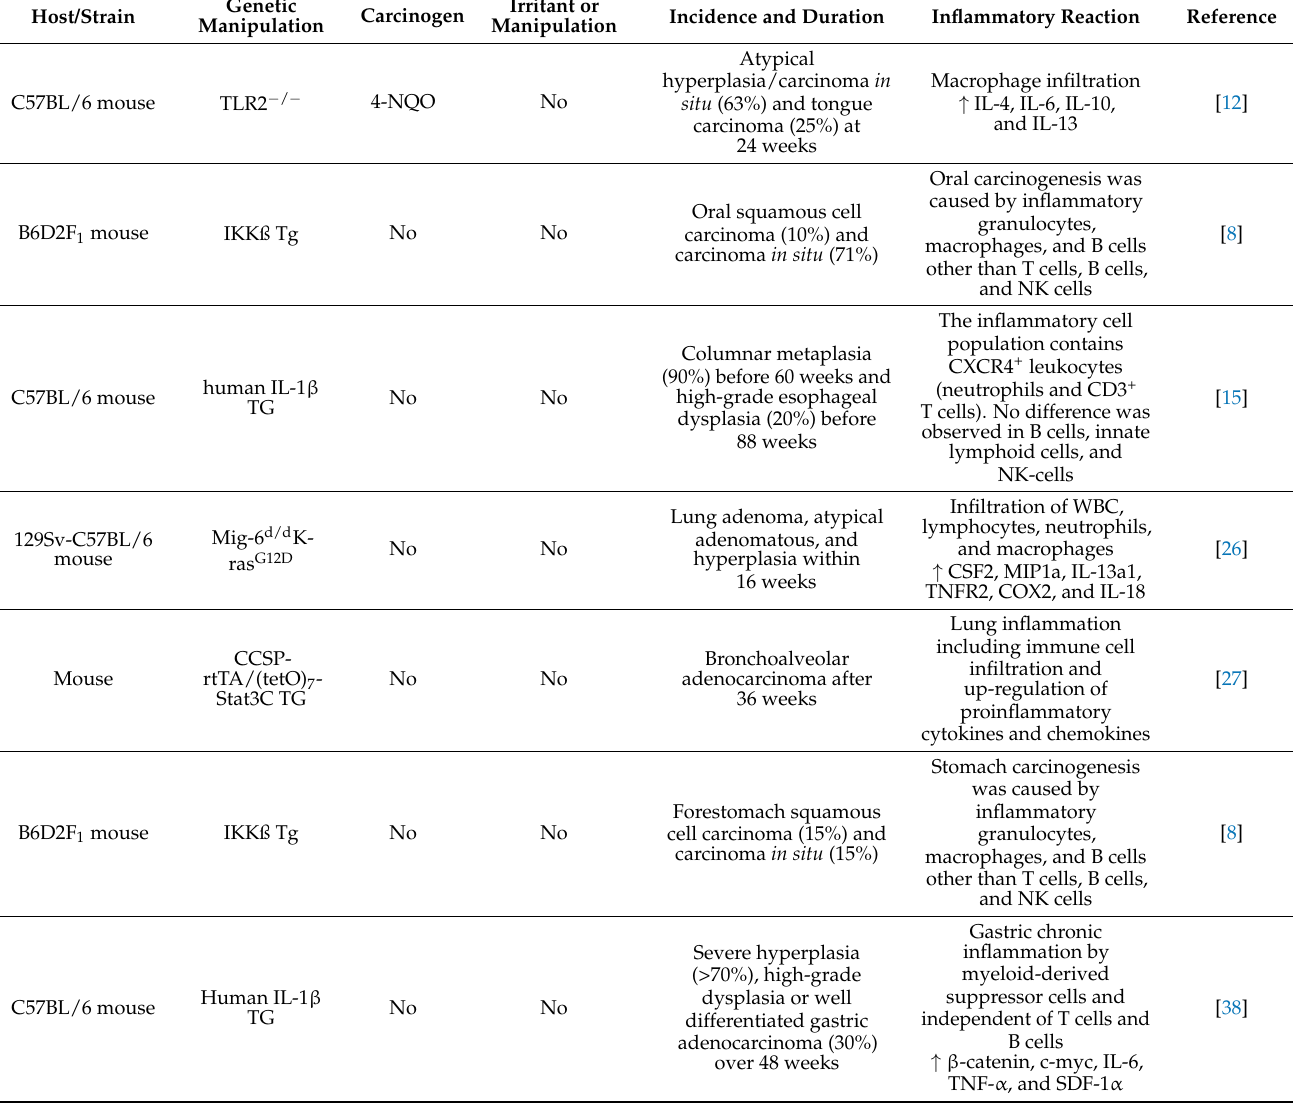
Table 3. Genetically modified host-induced inflammation-related carcinogenesis